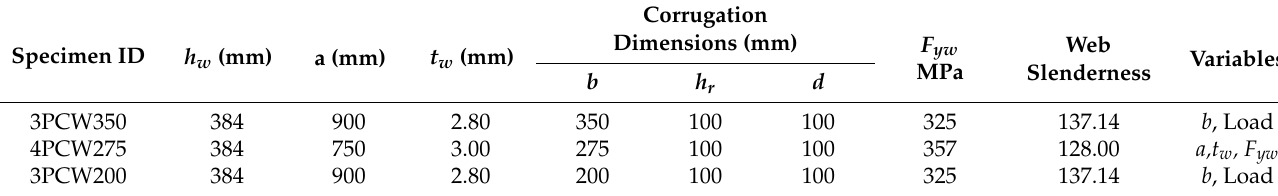
Table 1. Test data from the authors.